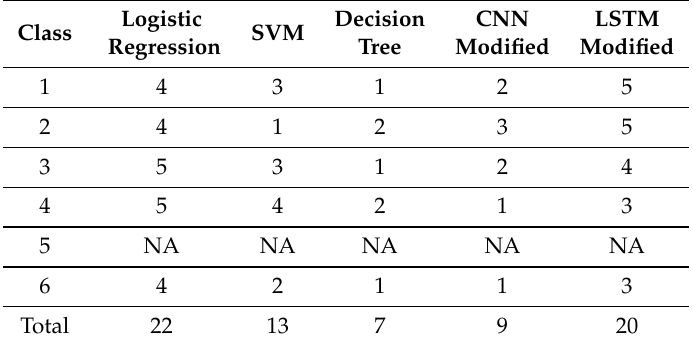
Table 15. Classifier performance rankings (Using the F1-scores from the CNN and LSTM classifiers with modified input data structures).